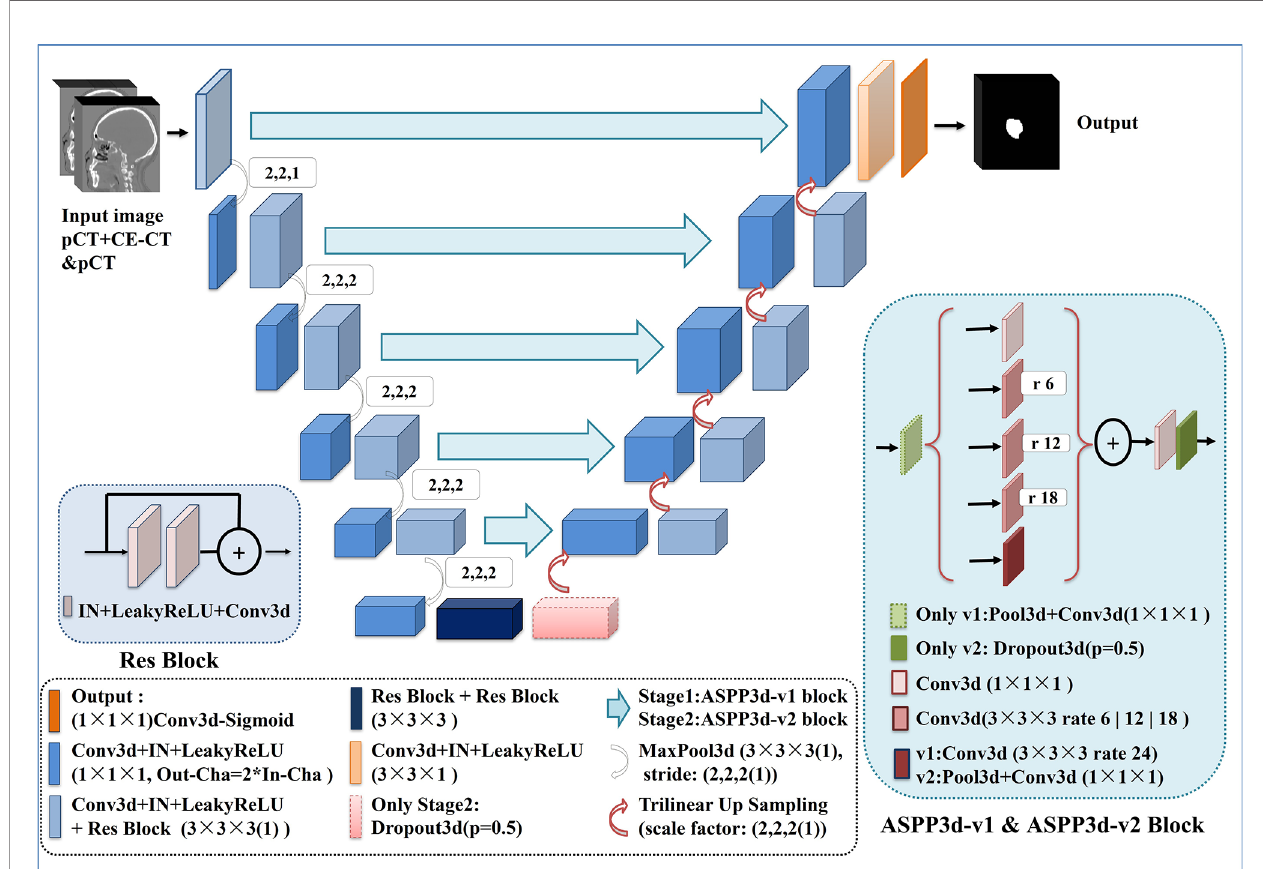
FIGURE 2 | Network architecture of the proposed CNN